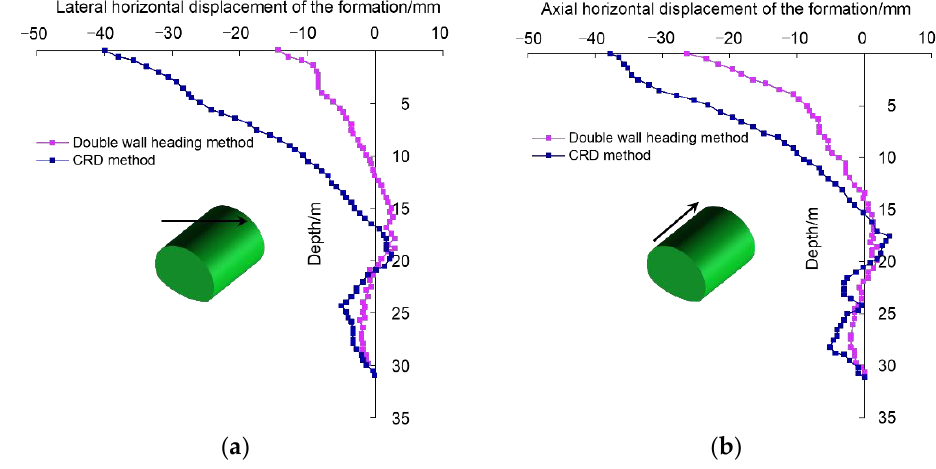
Figure 23. Horizontal displacement of the overlying ground of a tunnel [79]. ( a ) Lateral horizontal displacement of the formation; ( b ) axial horizontal displacement of the formation.